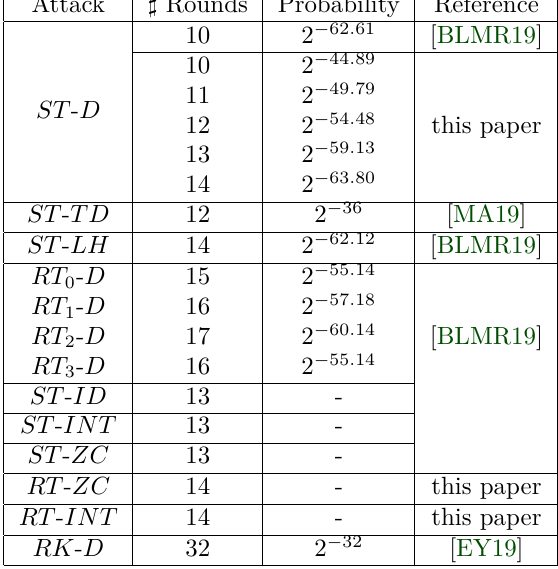
Table 1: Summary of the main results of attacks on CRAFT . Where ST , RT and RK denotes single tweak mode, related tweak mode and related key mode respectively and RT i denotes RT mode that is started with TK i . In addition, D , TD , LH , ID , INT and ZC denote differential effect, truncated differential, linear hull, impossible differential, integral, and zero-correlation cryptanalysis, respectively. For example, RT 0 - D denotes differential effect of CRAFT in related tweak mode, starting with TK 0 . Attack ] Rounds